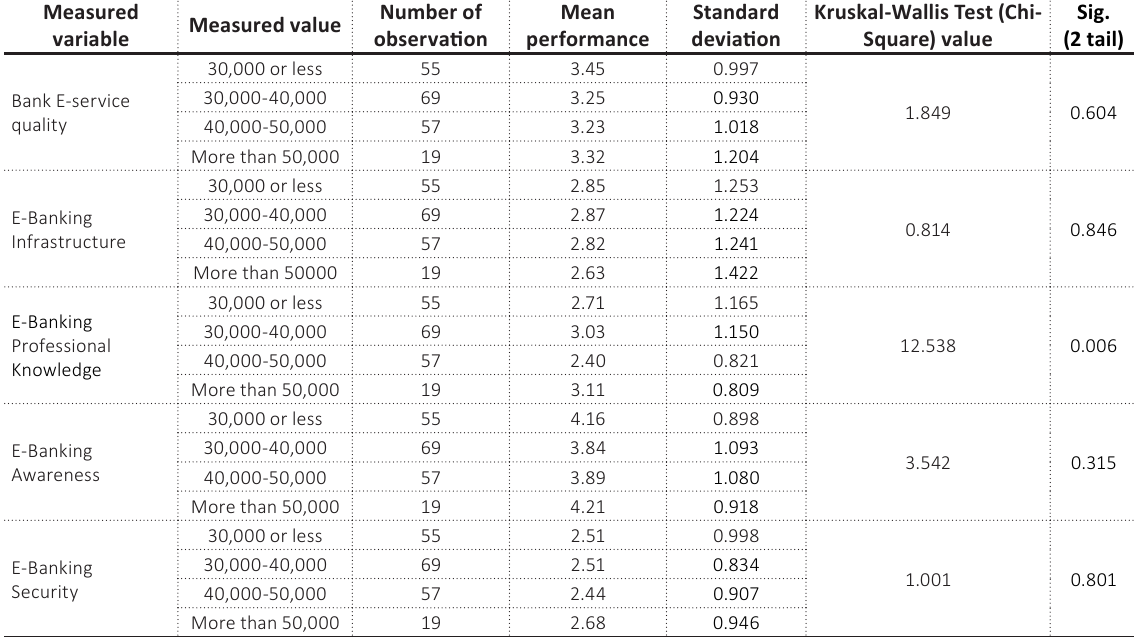
Table 7. Kruskal-Wallis test for income level Measured Measured variable